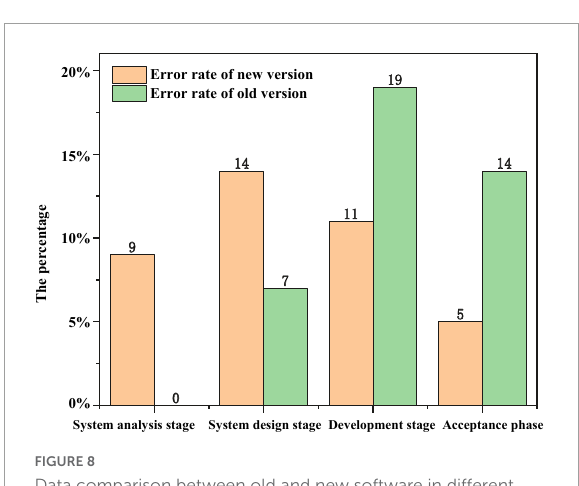
FIGURE7 Clustering analysis algorithm.